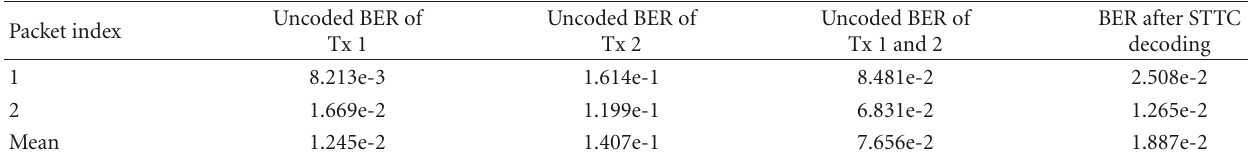
Table 3: BER of LB 2 × 8 MIMO with 8PSK